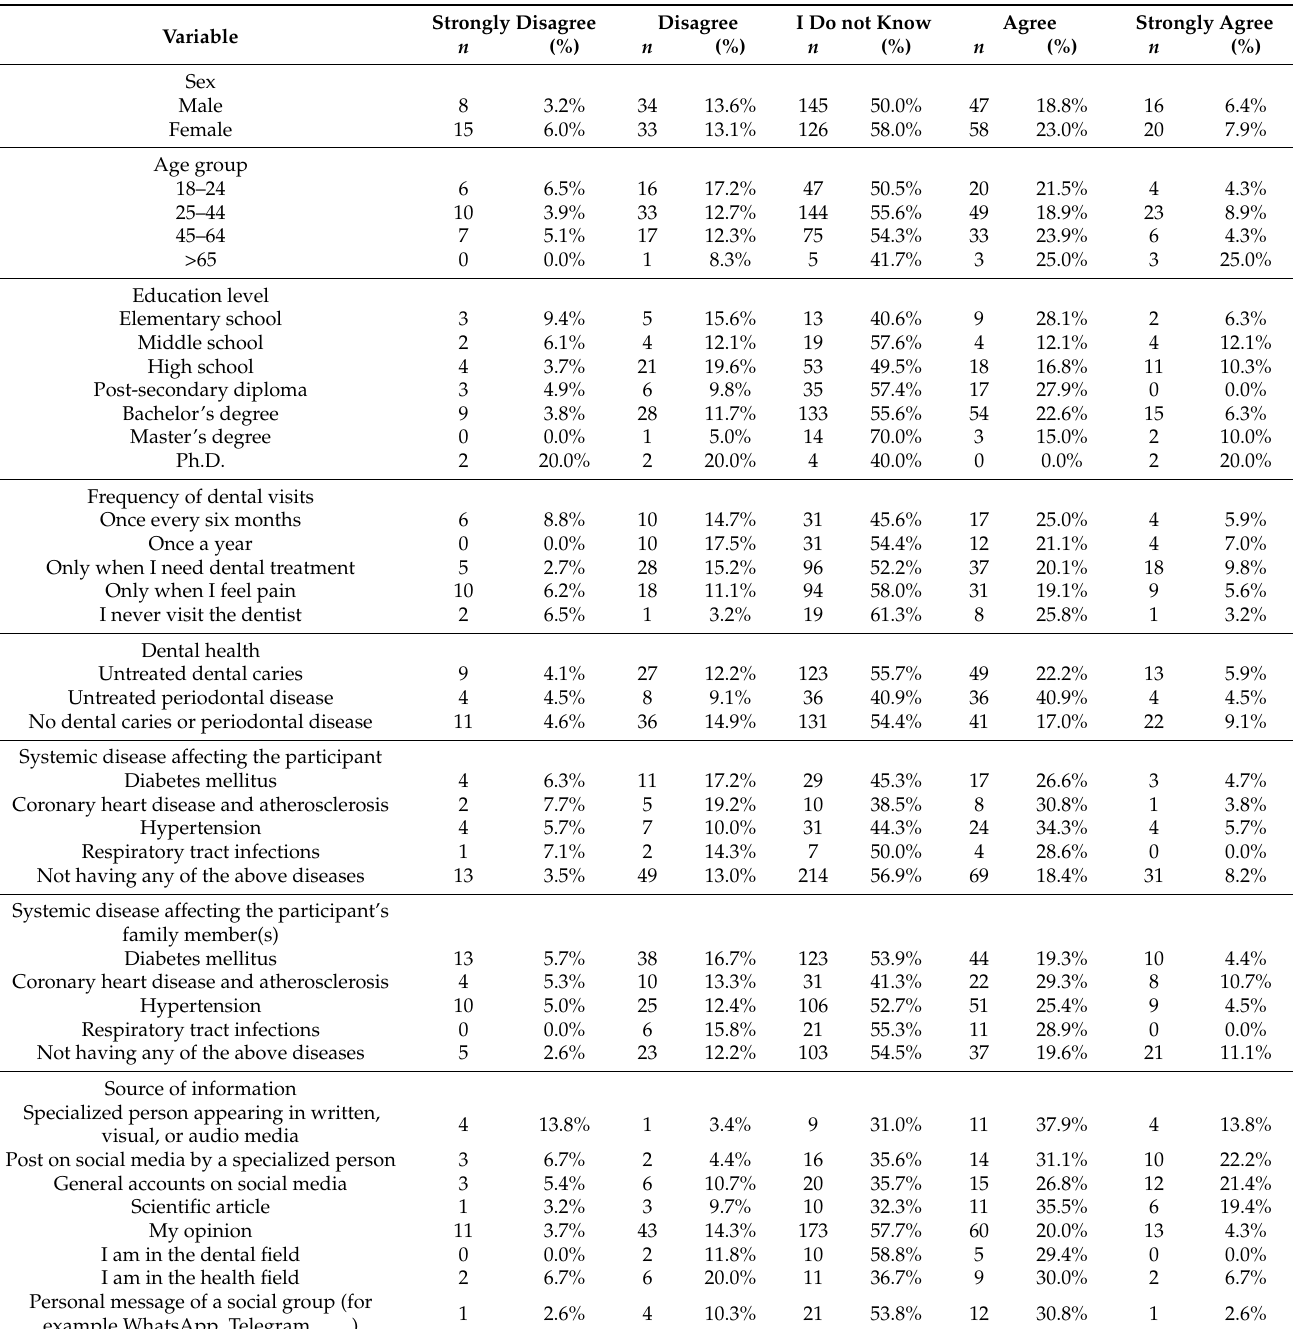
Table 11. Awareness about the association between periodontal disease and hypertension distributed by various